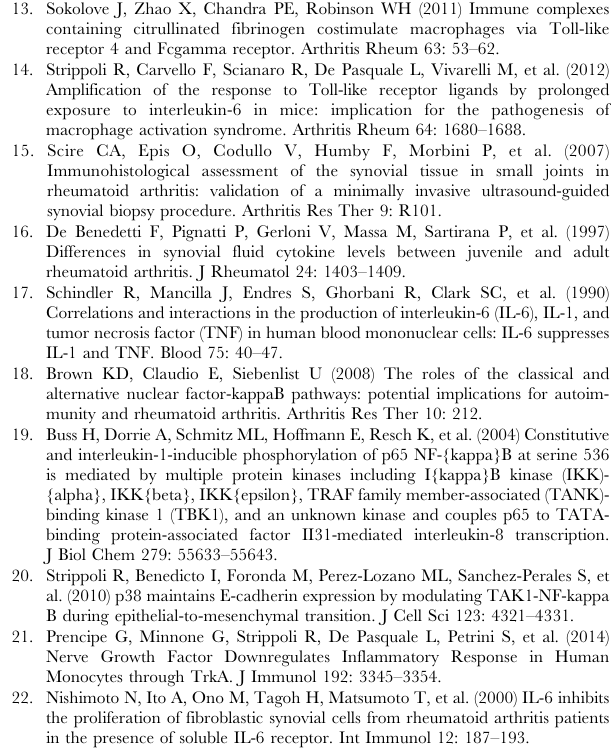
Figure S2 Exposure to IL-6 affects the production of IL1- b and CXCL8 in adherent human PBMCs in response to TLR ligands. Human PBMCs cells were left to